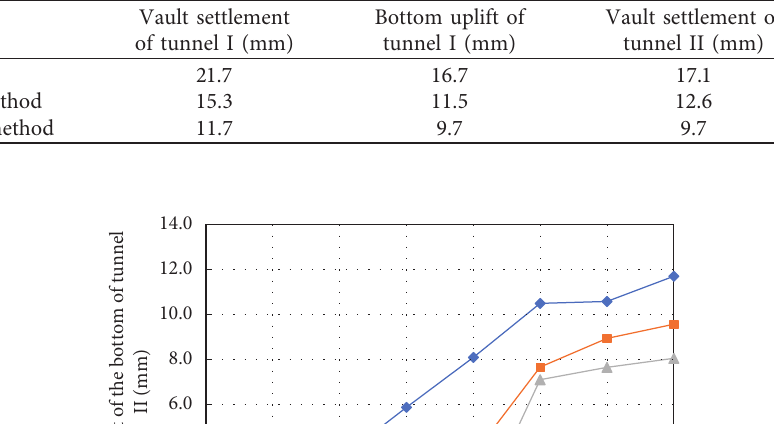
Table 6: Vertical displacement of surrounding rocks.